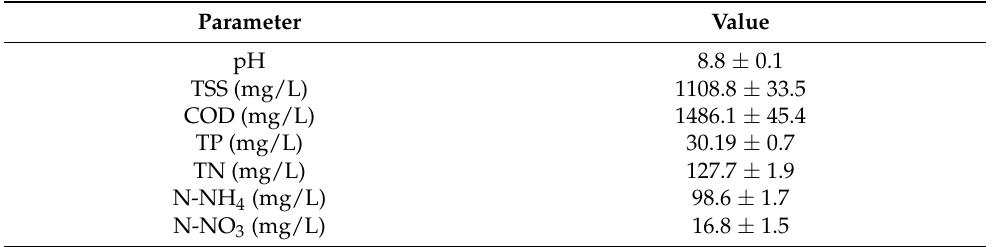
Table 1. Chemical characteristics of the municipal/swine wastewater used in this